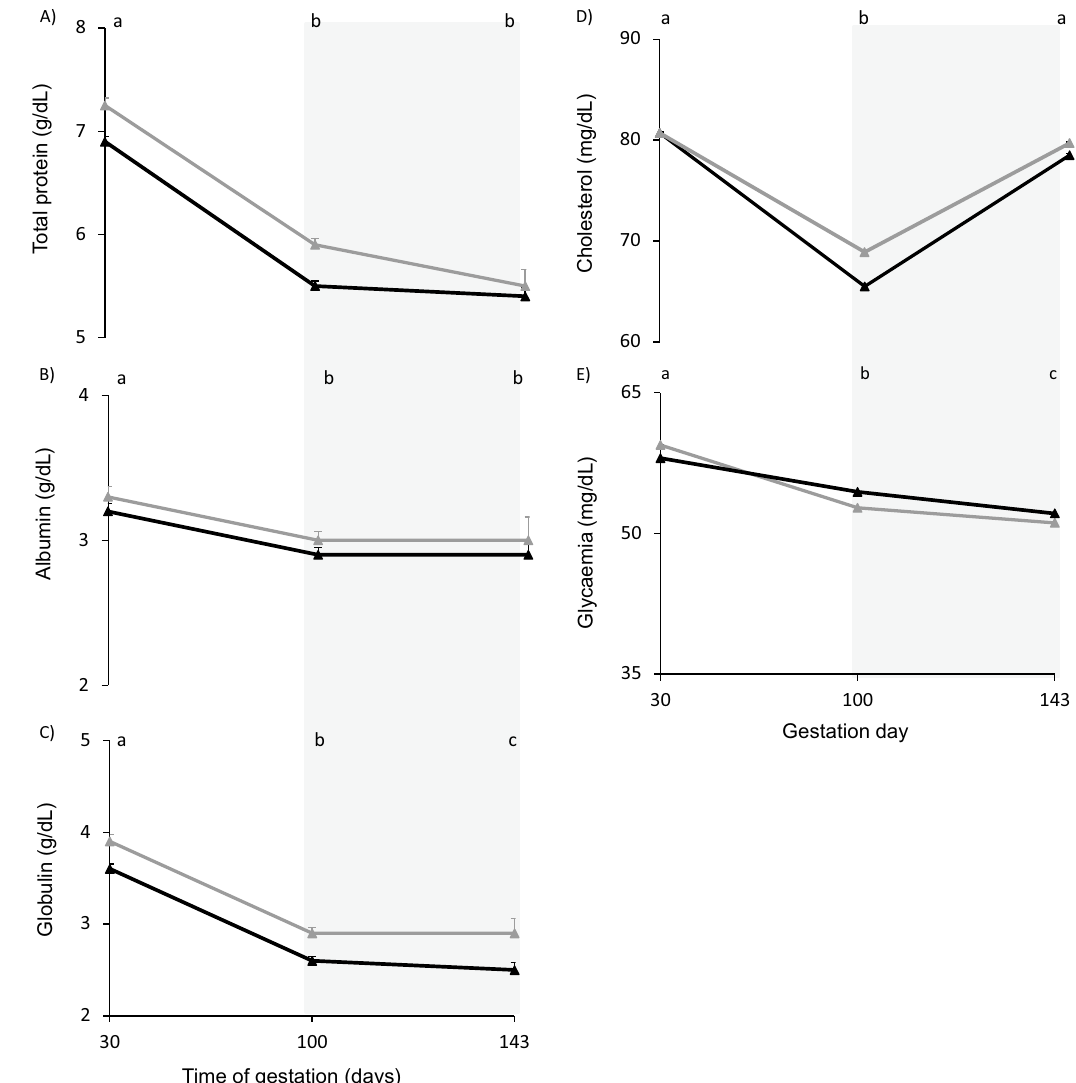
Figure 2. Total protein ( A ), albumin ( B ), globulin ( C ), cholesterol ( D ) and glucose ( E ) concentrations (LS mean ± s.e.m.) of multiparous (gray filled triangle) and primiparous (black filled triangle) ewes. Total protein and globulin concentrations were greater in multiparous than in primiparous ewes ( p < 0.02). Different letters indicate significant differences between the days ( P < 0.0009). The light grey area represents the period when all ewes were supplemented with 300 g/animal/day of rice bran. Multiparous N Primiparous N